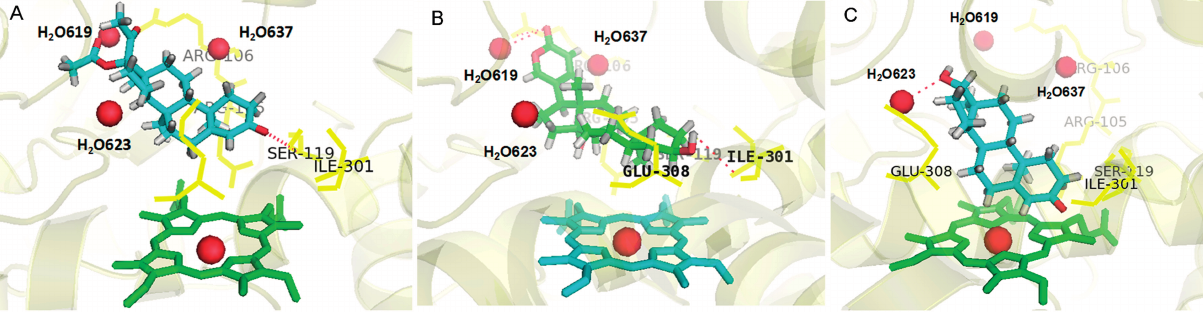
Figure 1. The binding modes of three typical substrates docked into the active cavity of CYP3A4 via hydrogen bond interactions; ( A ) medroxyprogesterone acetate (MPA); ( B ) bufalin (BF); and ( C ) testosterone. The important residues interacting with the bound substrate in the CYP3A4 complex are shown as yellow lines; the three water molecules are shown as red spheres; and the heme groups are shown as